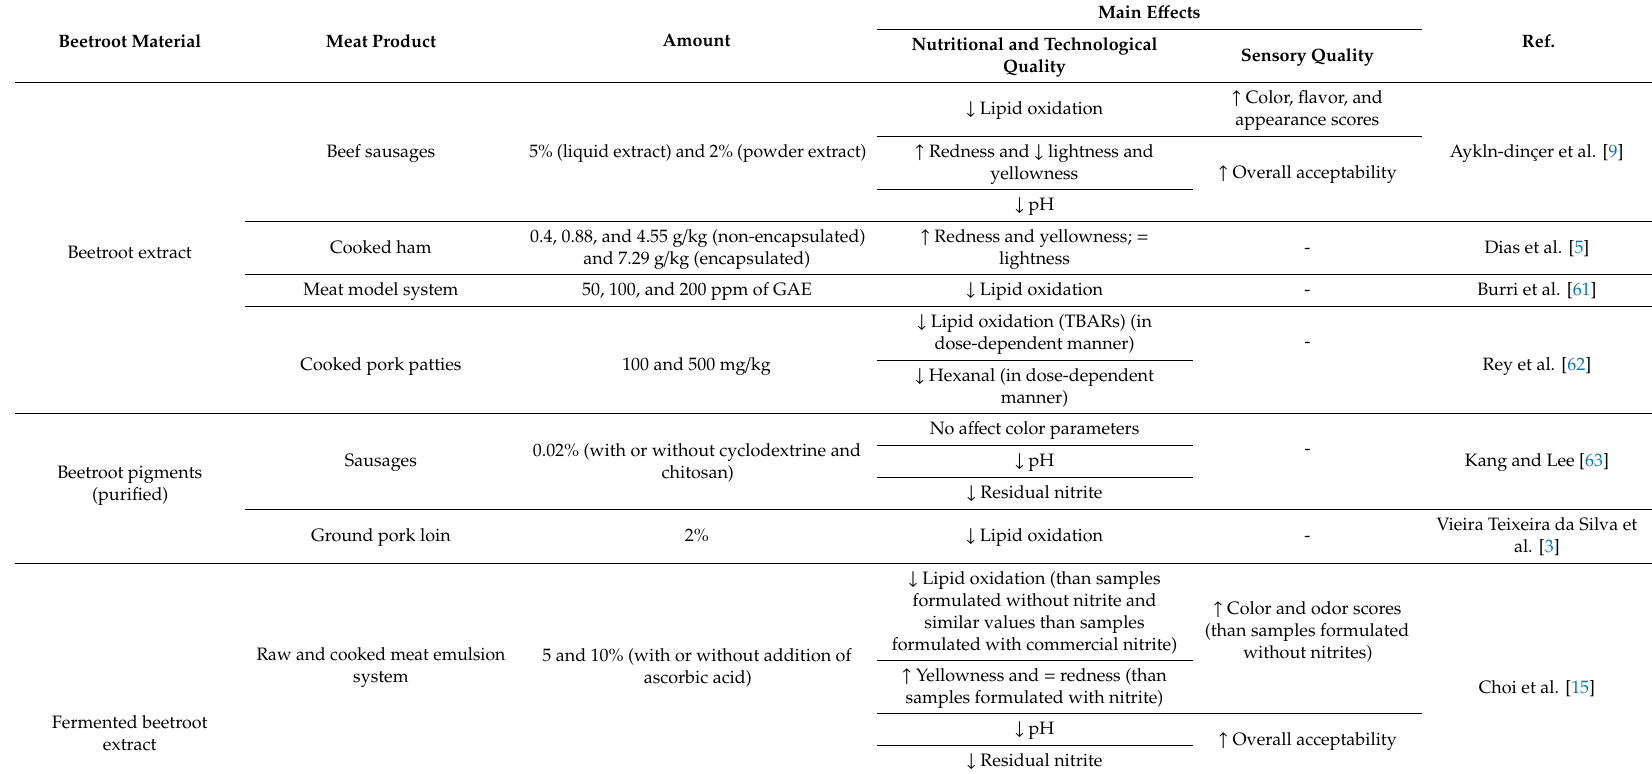
Table 4. Application of beetroot in the reformulation of meat